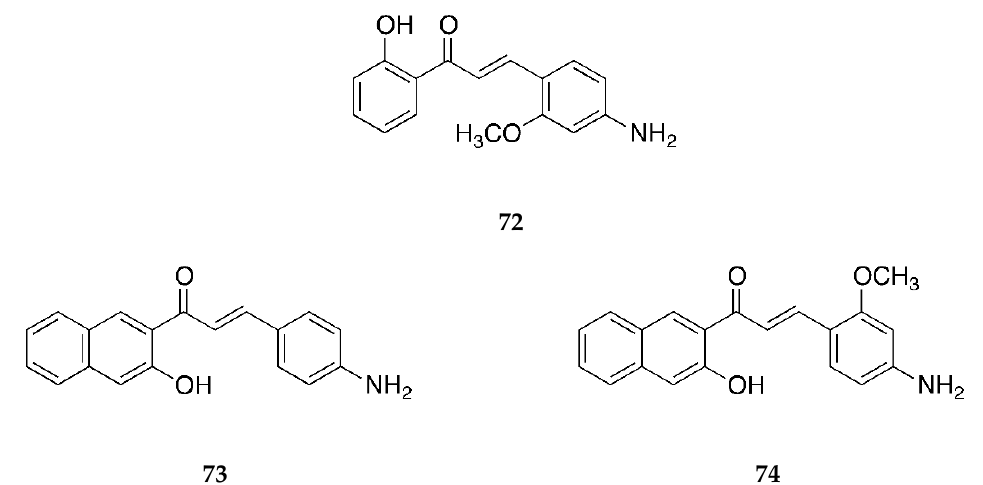
Figure 37. Chemical structures of the 4′-aminochalcone derivative with methoxy substitutions on ring